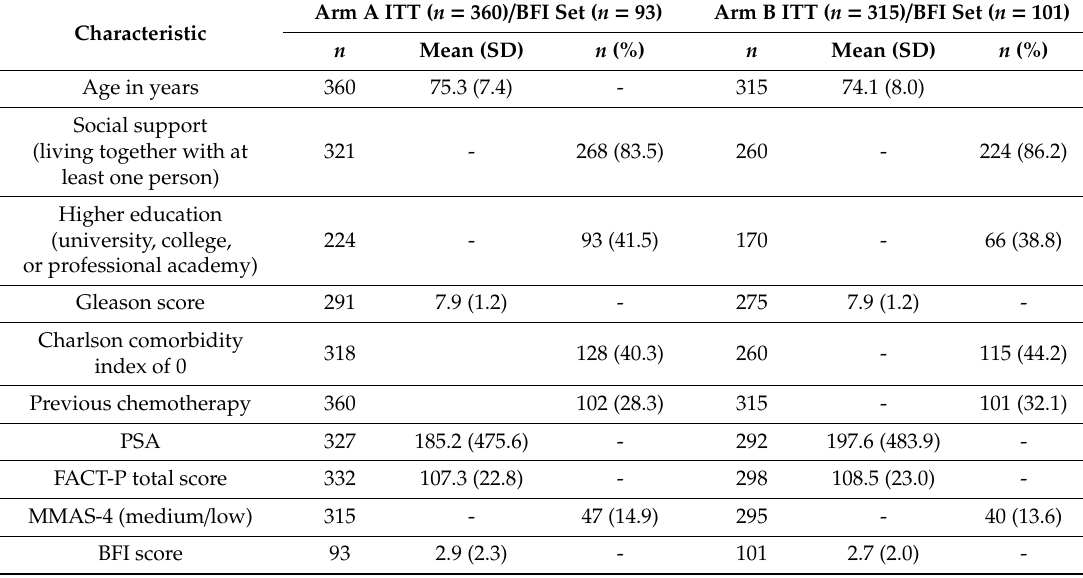
Table 2. Baseline